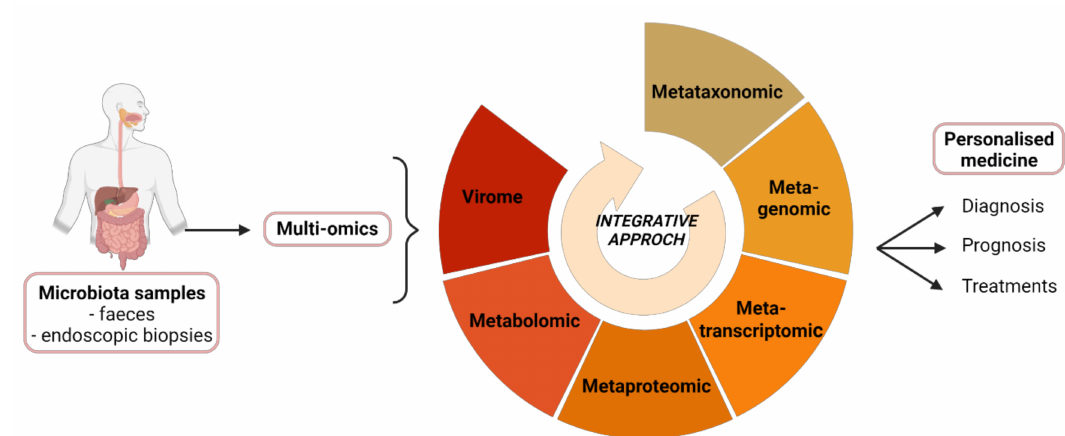
Figure 2. Integrative analysis of multi-omics data regarding the gut microbiota in IBD. The microbiome is characterized from stool samples or endoscopic biopsies, using multi-omics techniques. The provided data open up new horizons for the development of diagnostic, prognostic and therapeutic tools optimized for a personalized medicine. Created by